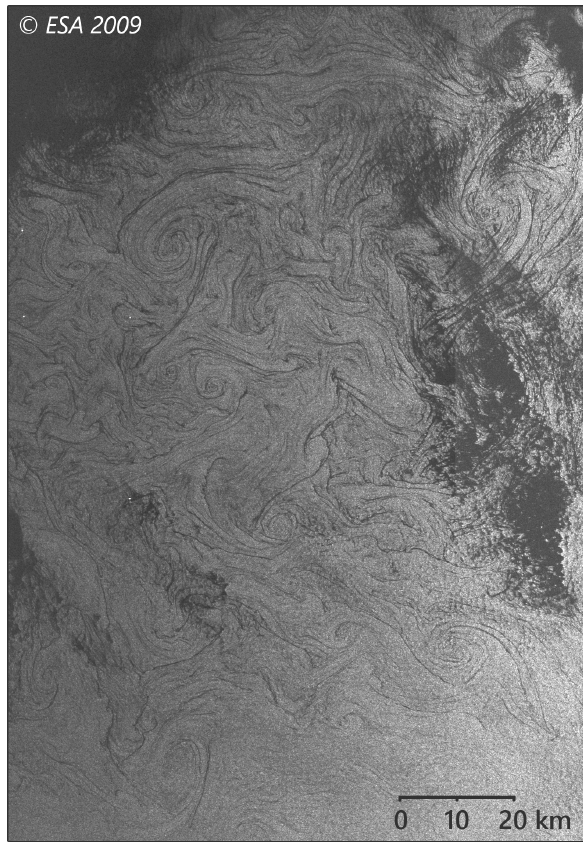
Figure 16. Submesoscale turbulent field in the area to the north- east from the Gulf of Lion, Envisat ASAR,